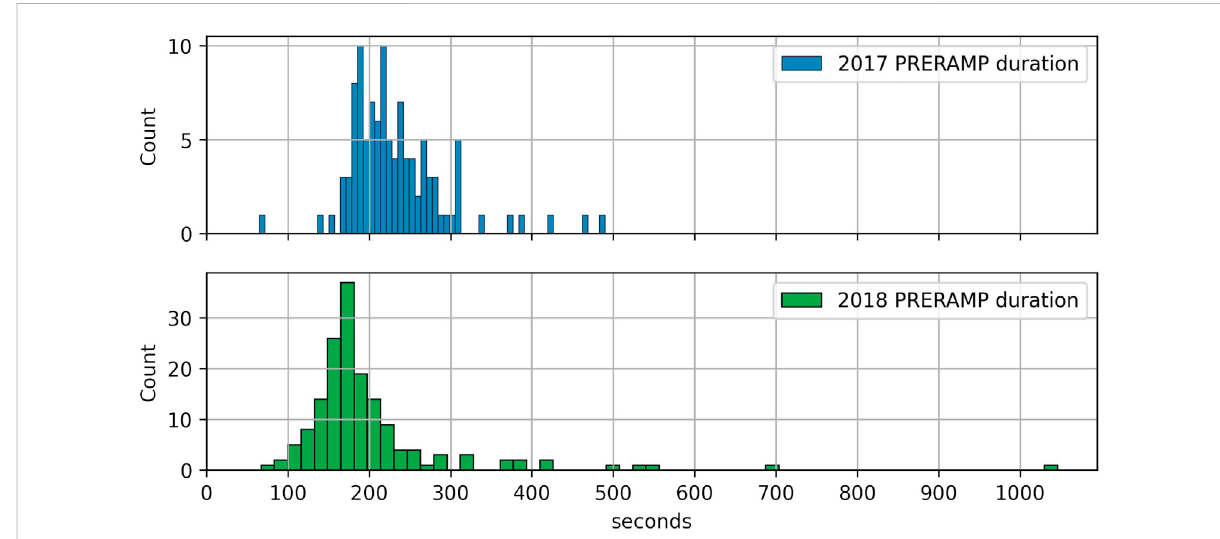
Histogram of PRERAMP time series lengths for the years 2017 and